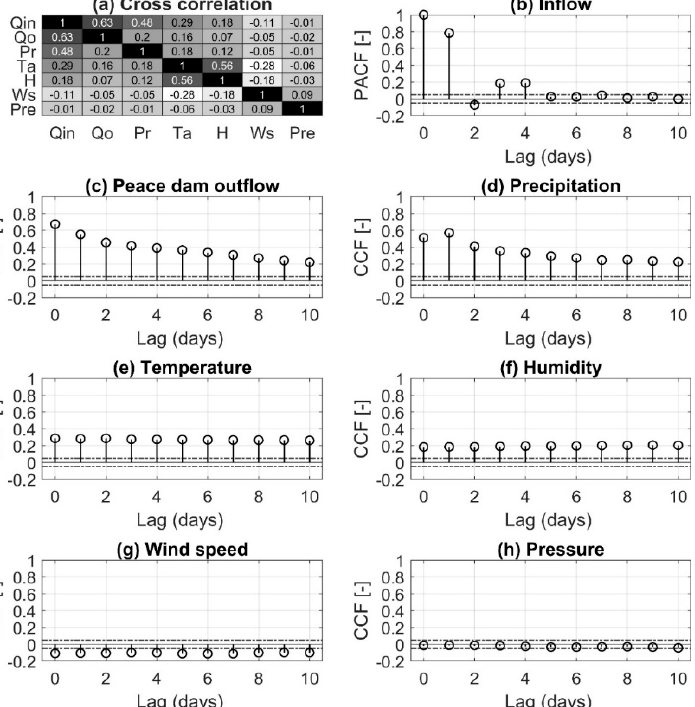
Figure 4. ( a ) Cross-correlation functions (CCF) between inflow to Hwacheon dam (Qin) and candidate input variables of outflow from Peace dam (Qo), precipitation (Pr), temperature (Ta), humidity (H), wind speed (Ws), and pressure (Pre); ( b ) partial autocorrelation functions (PACF) with time lags for Qin; ( c – h ) cross-correlation functions between Qin and the candidate variables at different lags. The black dot lines denote 95% confidence interval computed from Equation (12).